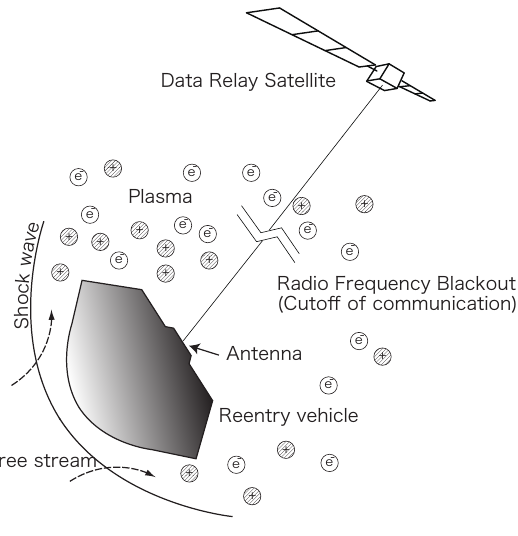
Figure 1. Schematics of radio frequency blackout during atmospheric